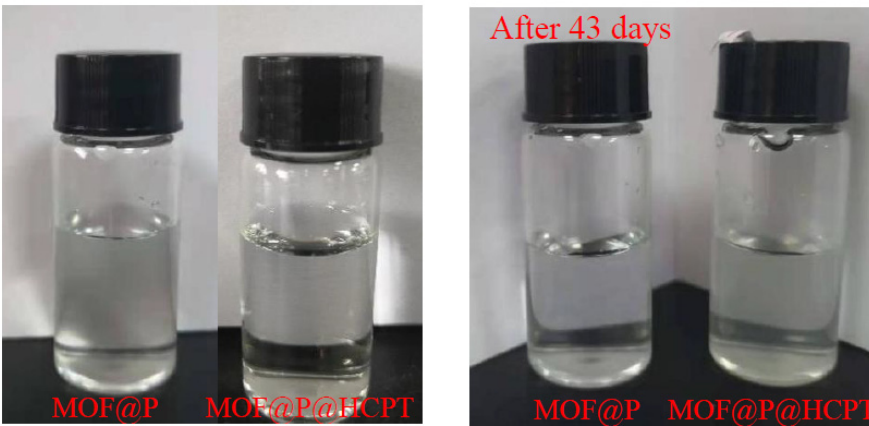
Figure 8. Photos of blank MOF@P and